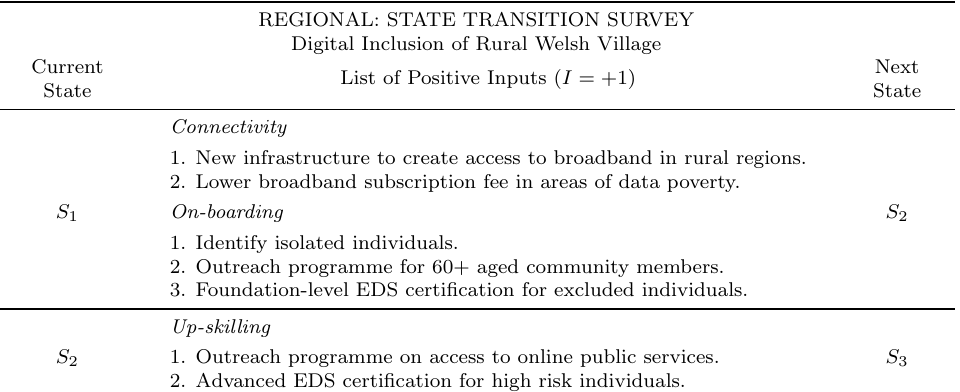
Table 4: State transition survey for rural Welsh